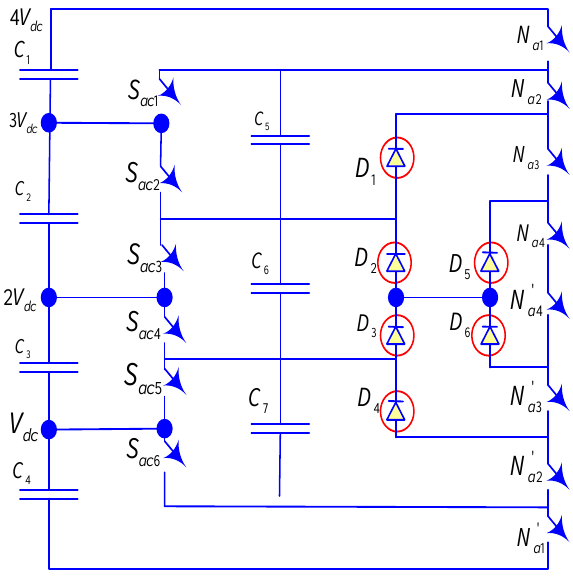
Figure 10. HC 5-level inverter.